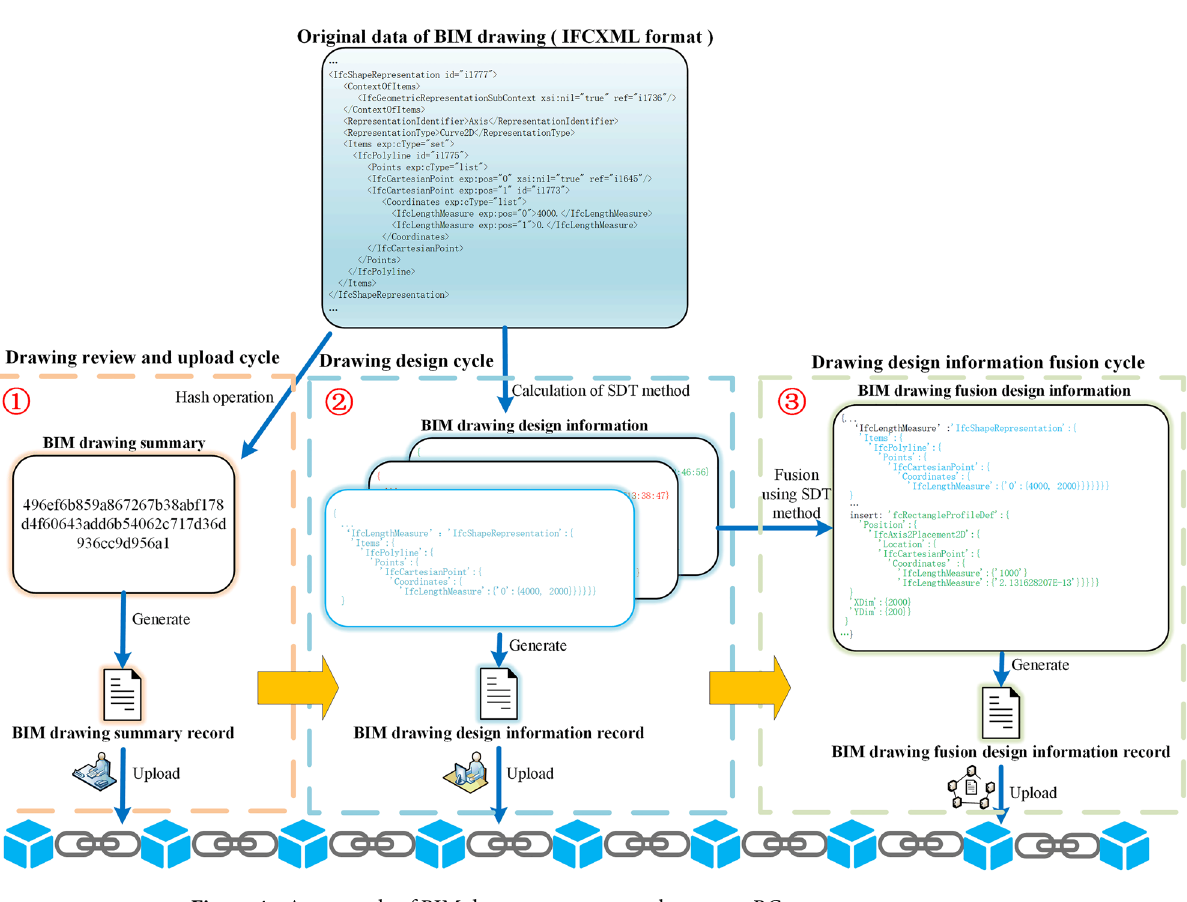
Figure 4. An example of BIM data storage content changes on